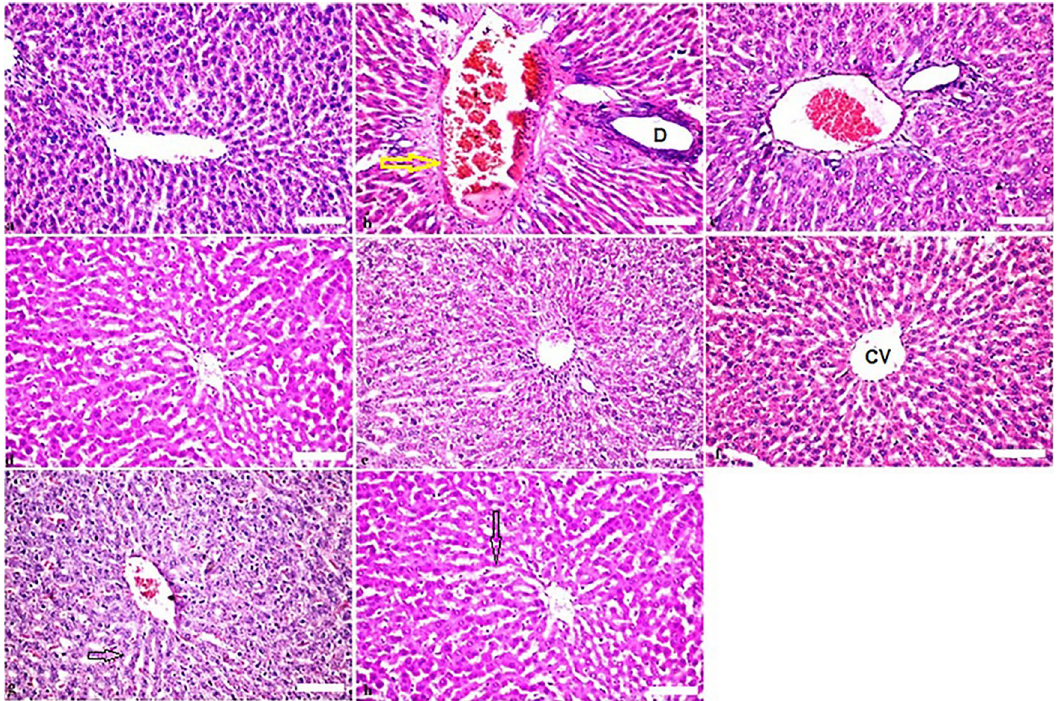
Figure 6. Histopathological findings in liver; (a) non-treated rats manifesting the typical histological architecture of the liver, (a) , (b) gamma rays at dose 6 Gy showing congestion in the portal vein (score 3) (yellow arrow) and dilatation in the bile ducts (D) (score 2), associated with fibrosis (score 2) in the liver. (c) Rats were received of BV 0.05 mg/kg showed there was no histopathological alteration (score 0) as recorded in liver. (d) Rats were administered of propolis 300 mg/kg showed no alteration (score 0) of liver. (e) Effect of combination treatment of propolis + BV 300 & 0.05 mg/kg showed normal histological structure (score 0) in liver. (f–h) Effect of propolis 300 mg/kg and BV 0.05 separately and combined (respectively) on the normal rats for two weeks without any alterations in liver. Normal hepatocytes radiating from the central vein (CV) and separated by blood sinusoids (arrows) (f–h) . H&E stain